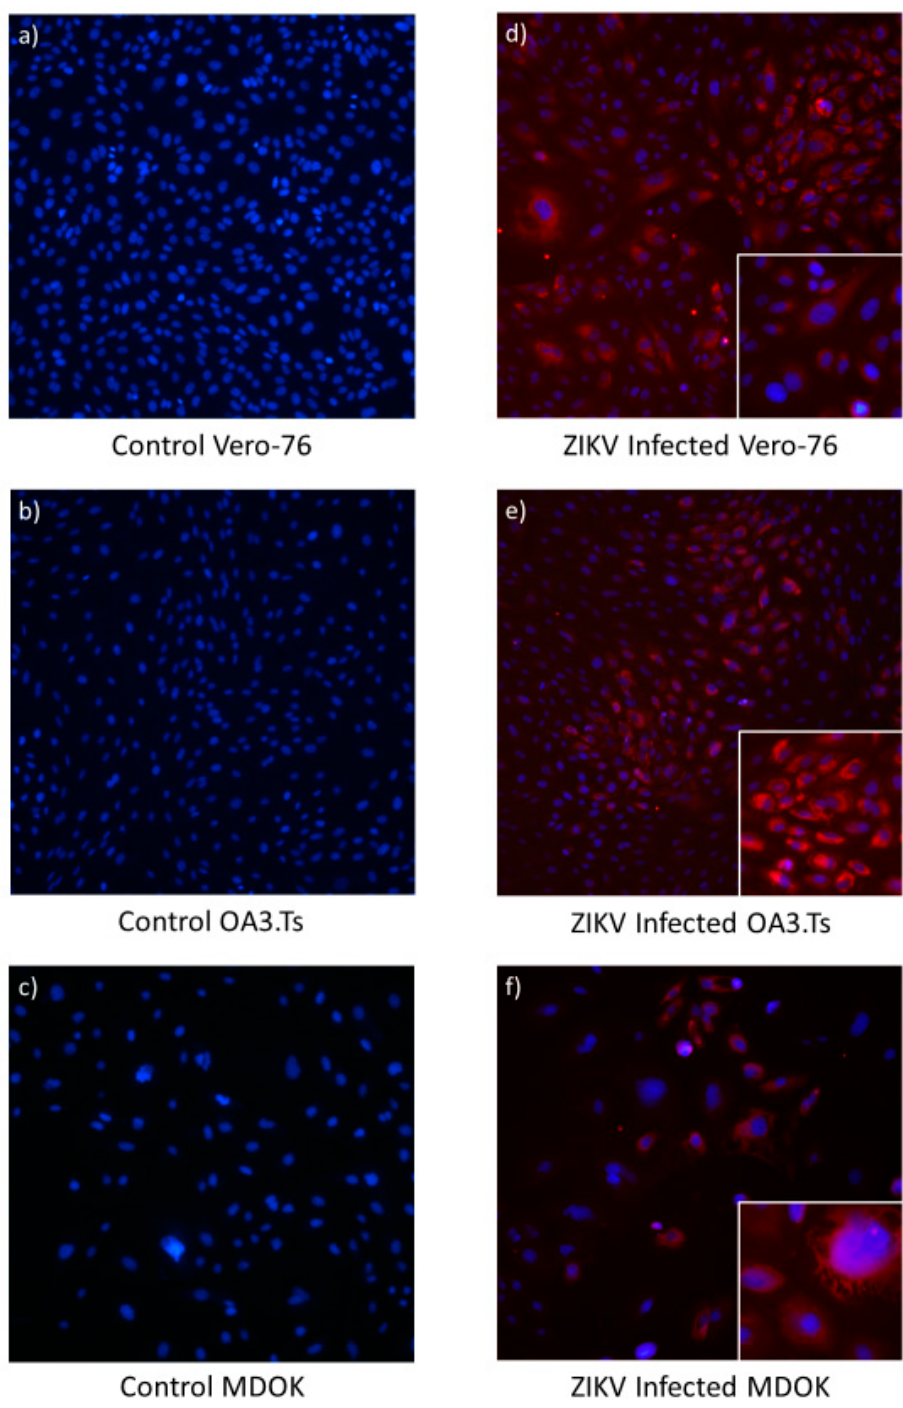
Figure 8. Photomicrograph comparing uninfected and ZIKV infected Vero-76 ( a and d ), OA3.Ts ( b and e ), and MDOK cells ( c and f ) at 48 h PI. The nuclei of both infected and uninfected cells were stained with DAPI ( blue ), while immunofluorescence ( red ) illustrates the perinuclear and cytoplasmic presence of the ZIKV E protein in infected cells (panels d – f ). All large panels are shown at 10 × magnification, while smaller panels in the lower right-hand corner of panels d–f illustrate individual infected cells at 20 ×